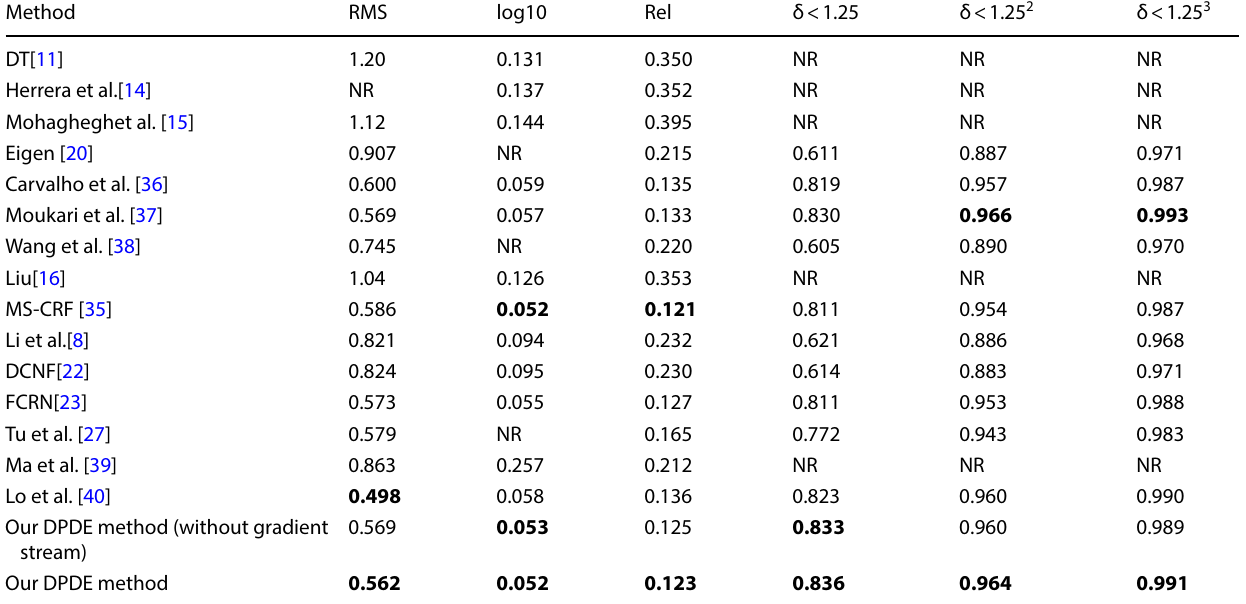
Bold indicates the best and second best